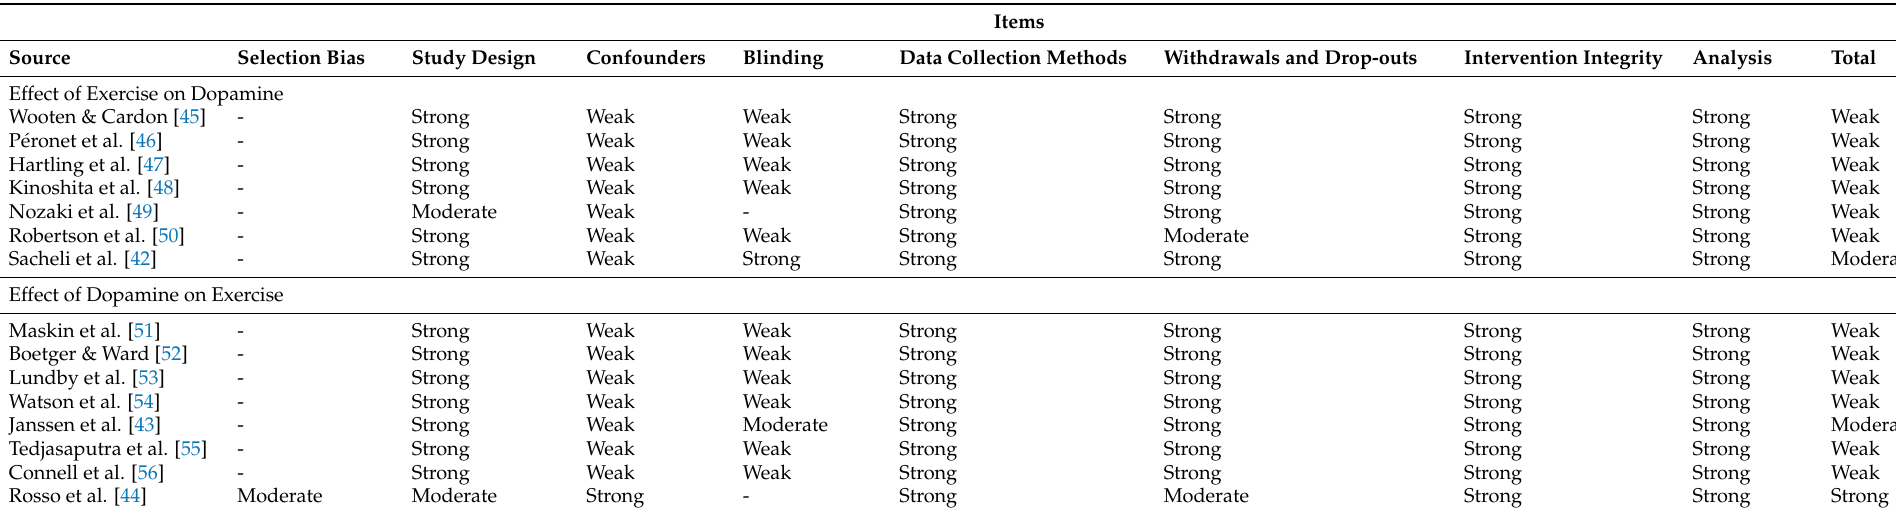
Table 1. Quality